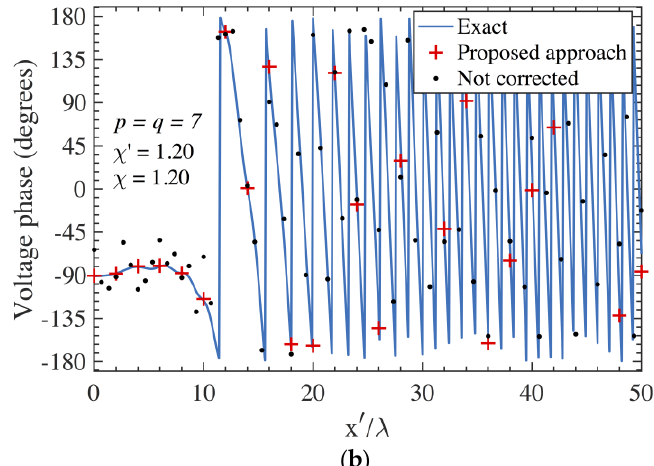
Figure 6. V y on the scanning plane at y (cid:48) = 13 λ − AUT 2. Blue line: exact. Red crosses: obtained from the positioning errors corrupted PWMS samples by using the devised multi-steps procedure. Black dots: obtained from the positioning errors corrupted PWMS samples without using the devised procedure. ( a ) Amplitude. ( b ) Phase.